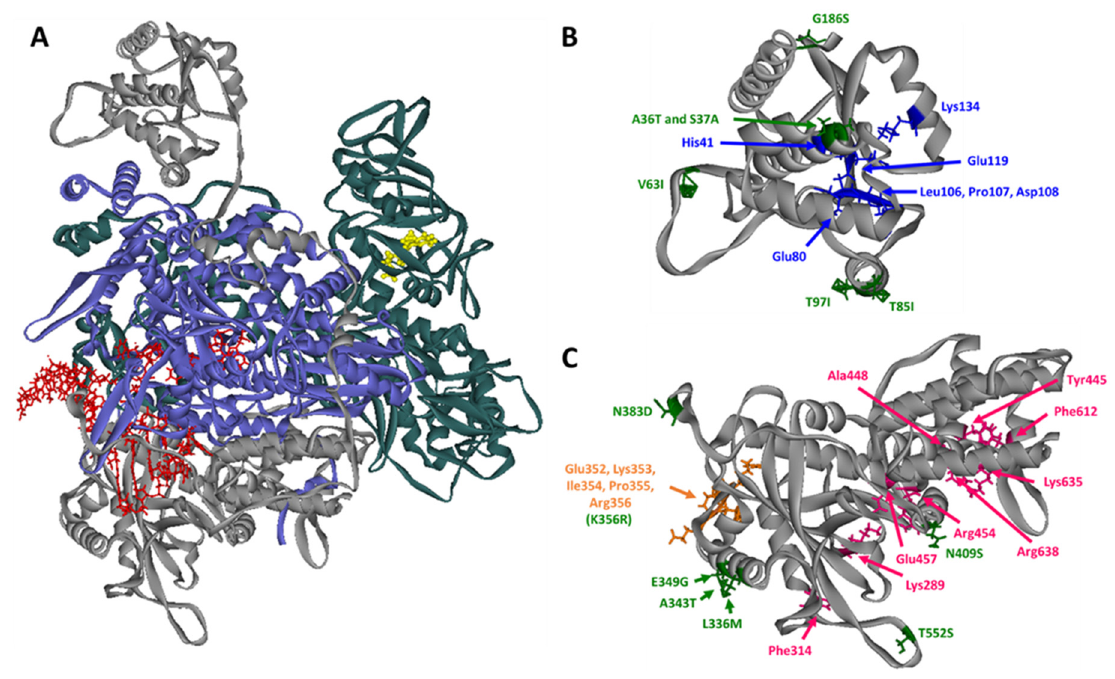
Figure 1. Structure of the Influenza A virus (IAV) polymerase and host adaptive mutations in PA. ( A ) Human H3N2 polymerase structure (PDB:6RR7) [6]. The PA subunit is colored gray, PB2 subunit is colored teal, and PB1 subunit is colored blue. Viral genome (vRNA) bound to the PB1 and PA subunits is colored red and a 5’ 7-methylguanosine (m7G)-capped substrate bound to PB2 is colored yellow. ( B ) Detailed view of the PA endonuclease domain with host adaptive mutations is indicated in green and residues involved in endonuclease activity are indicated in blue. ( C ) Detailed view of the PA C-terminal domain with host adaptive mutations indicated in green, residues involved in binding to RNA Pol II C-terminal domain peptides in pink, and residues involved in dimerization in orange.